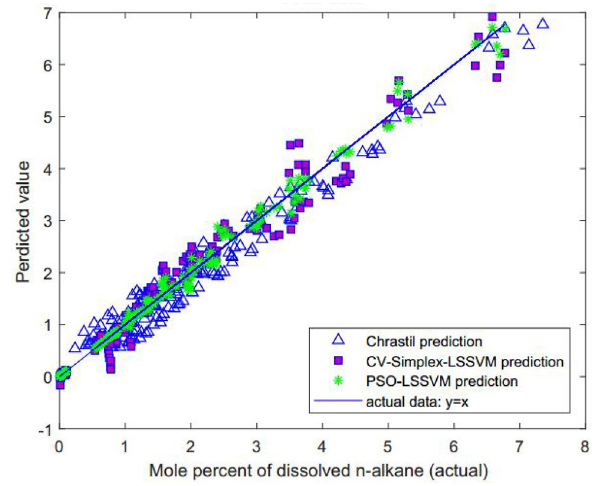
Fig. 4 PSO–LSSVM predicted mole percent of dissolved n -alkane for testing dataset